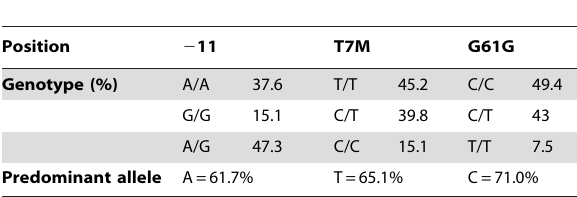
Table 1. Human SPRN